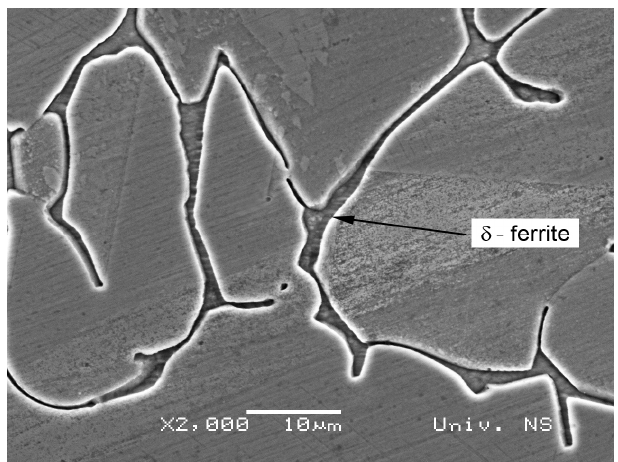
Figure 5. Scanning electron microscope (SEM) image of the δ -ferrite in the weld metal of the 5Ti specimen.